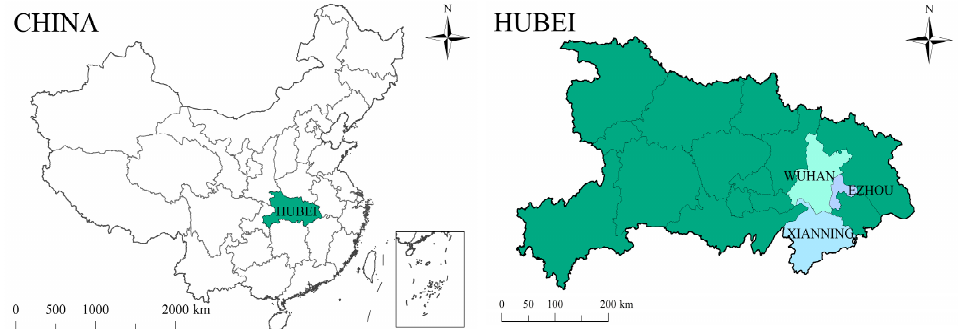
Figure 2. Location of the study area. Table 1. Basic characteristics of